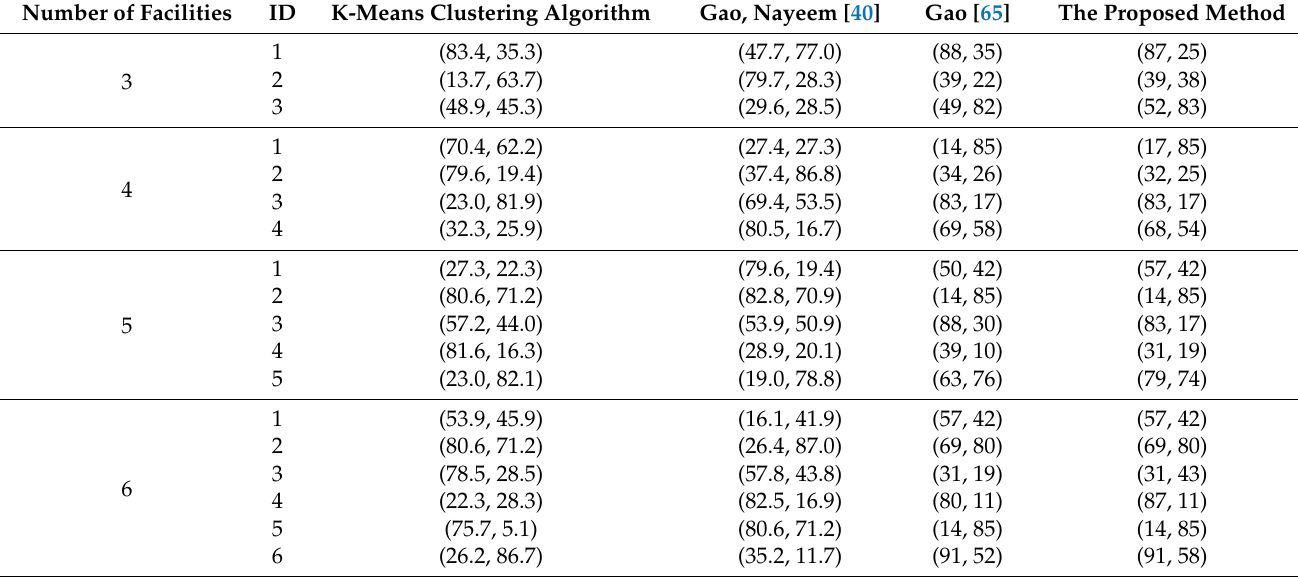
Table 9. Comparison of facility locations using different methods for Instance